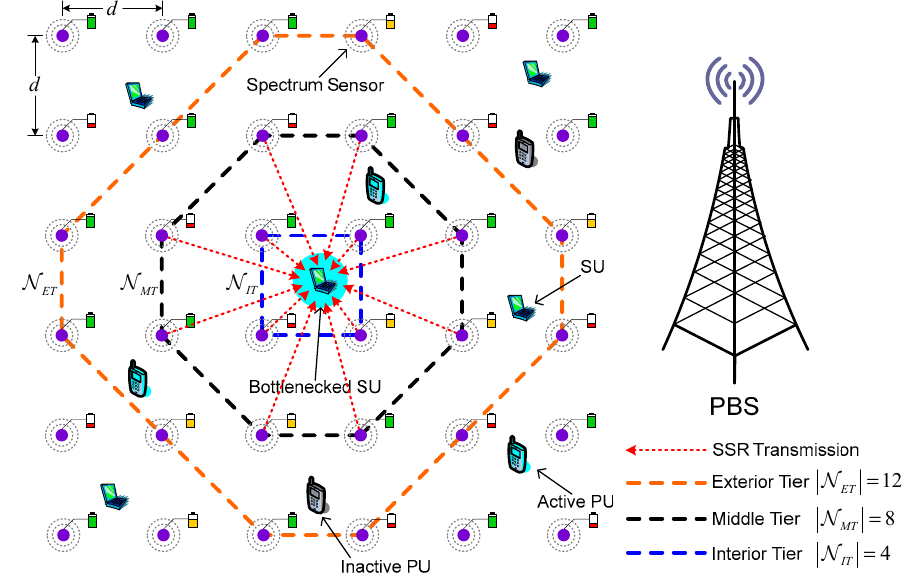
Figure 1. Illustration of the rectangular grid based SN-CRN. SU: secondary user; PU: primary user; PBS: primary base station.